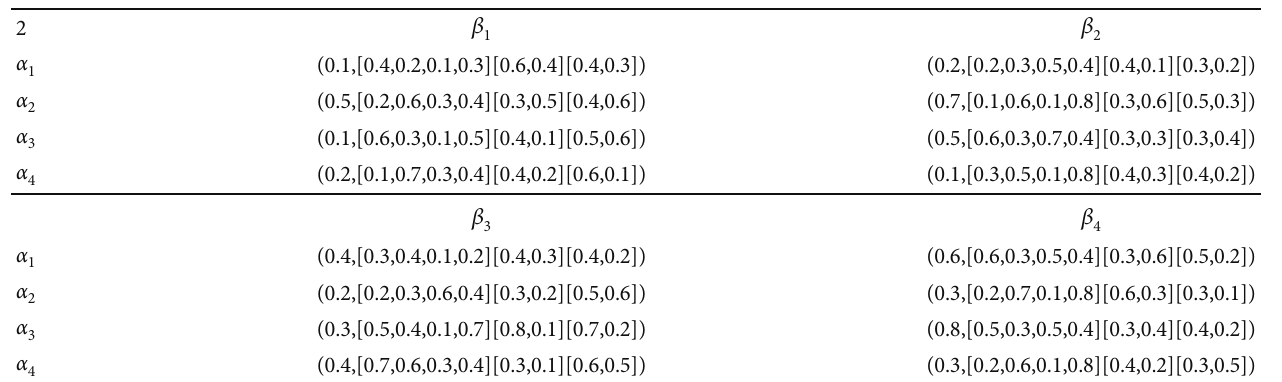
Table 2: Decision matrix of expert -2 (H 2 ).